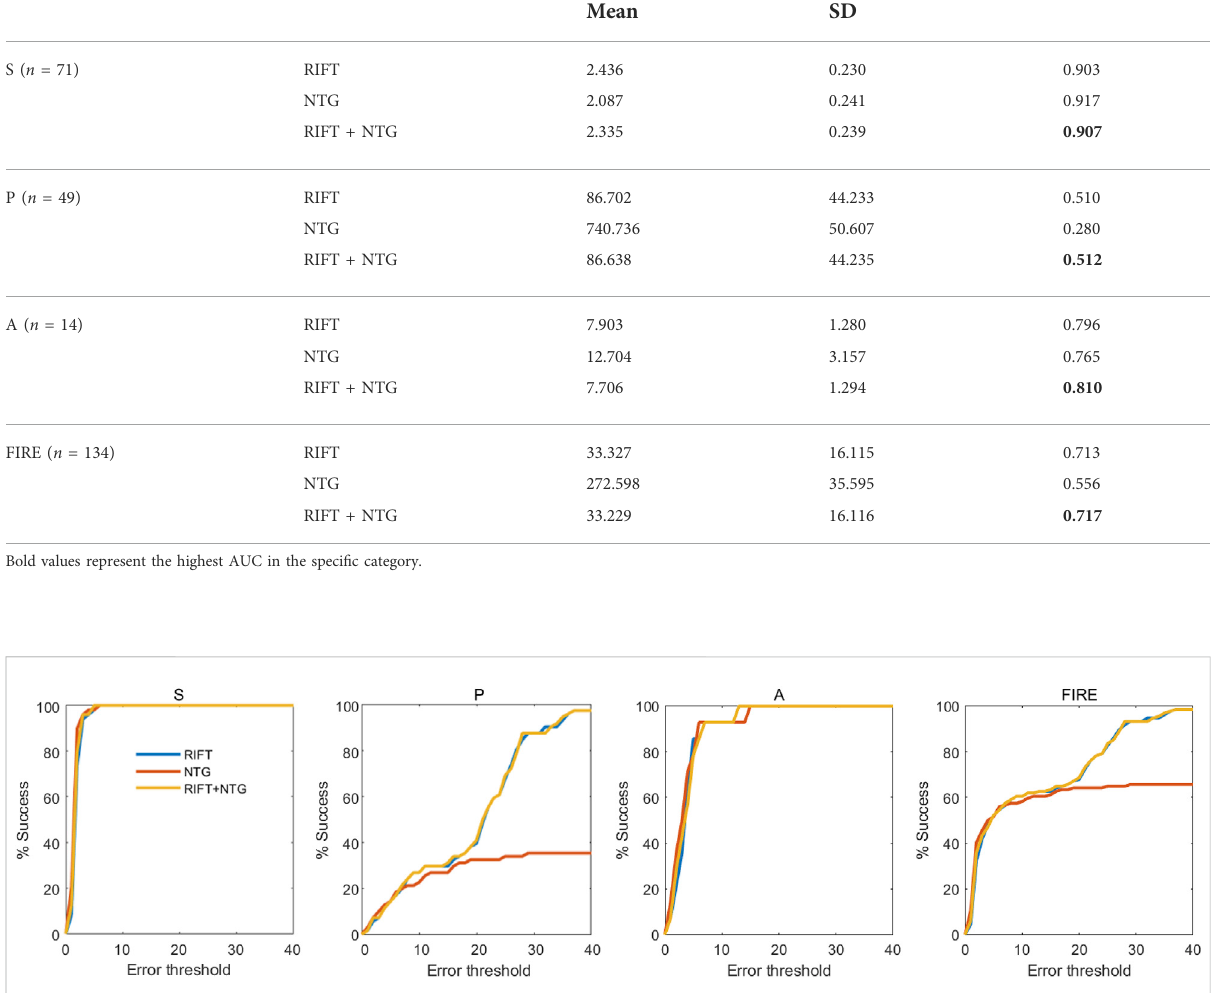
TABLE 1 Results of the ablation study in the FIRE dataset.